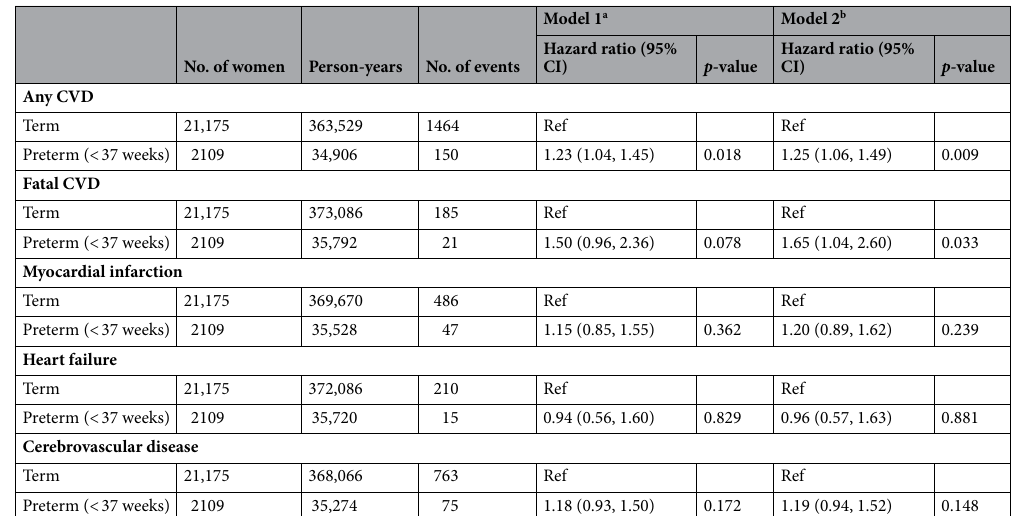
Table 3. Hazard ratios for cardiovascular events in women by history of preterm birth. a Adjusted for age. b Adjusted for age, highest obtained educational level, parity before age 40, maternal birth year, maternal height and family history of coronary heart disease. CI confidence interval, CVD cardiovascular disease.